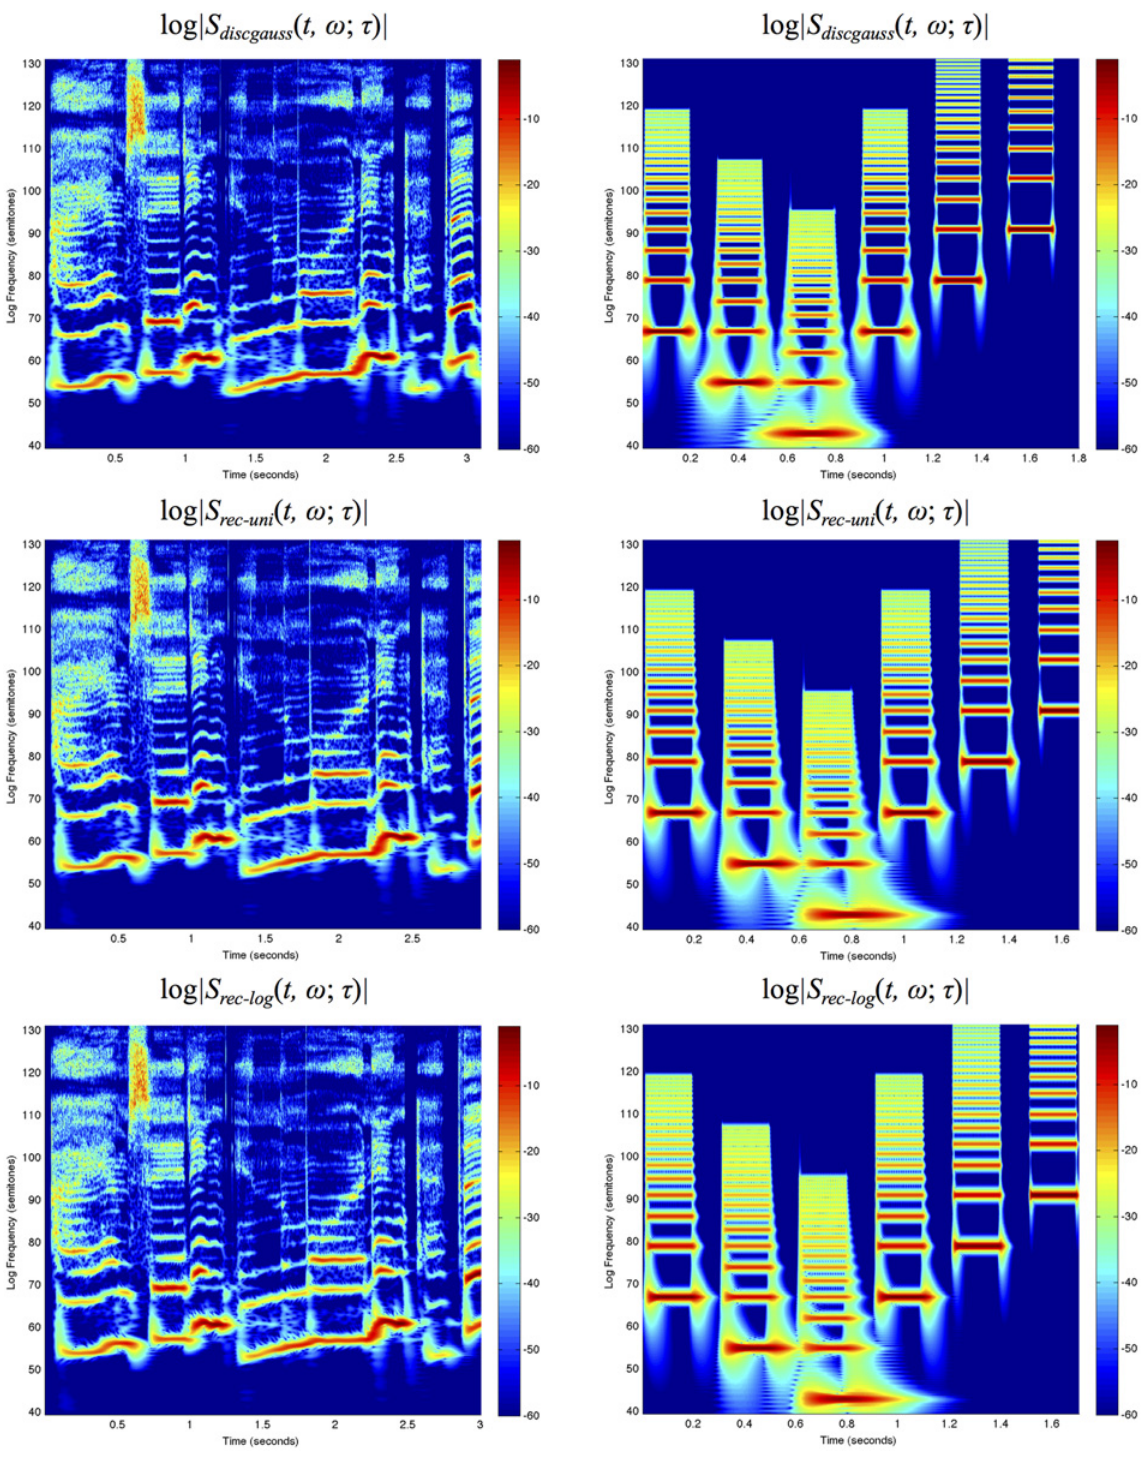
Fig 8. Spectrograms with the temporal window scale proportional to the wavelength according to Equation (73) for n = 8 and a soft lower ffiffiffiffiffiffi p ¼ 1 ms computed using different temporal scale-space concepts for (left column) the first 3 seconds of “ Tom ’ s diner ” by t 0 threshold s 0 ¼ Suzanne Vega with the lyrics “ I am sitting in the morning at the ... ” and (right column) a synthetic signal containing harmonic spectra with different ground tones over a logarithmic frequency range from 80 Hz to 16 kHz using 48 frequency levels per octave: (top row) the discrete analogue of the Gaussian kernel, (middle row) a cascade of seven time-causal recursive filters having a uniform distribution of the temporal scale